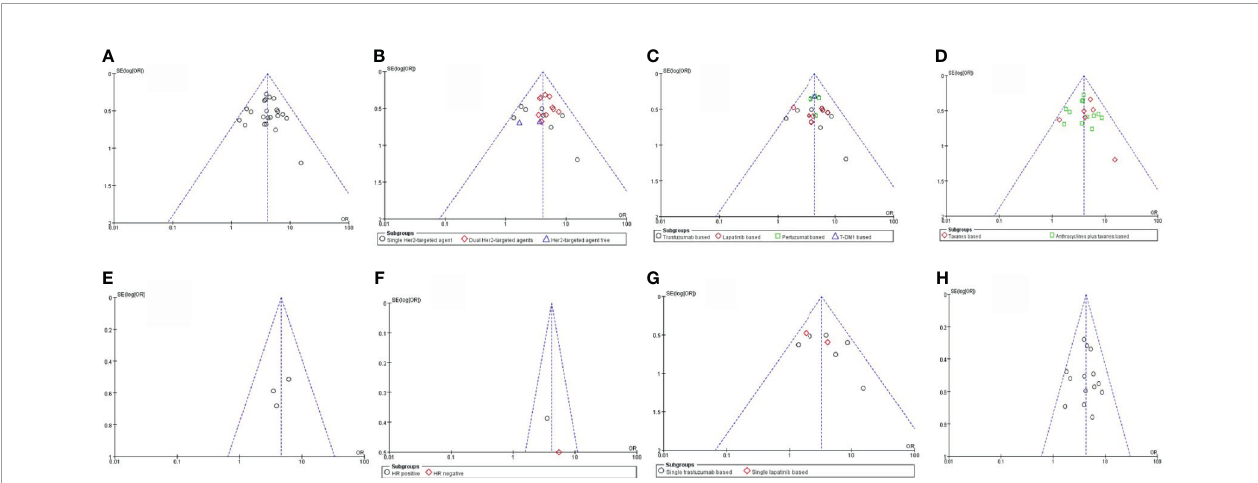
FIGURE 2 | Risk of bias assessment. (A) Her2-enriched vs Non-Her2-enriched subtype (B) The number of Her2-targeted agents (C) The category of Her2-targeted agents (D) Different chemotherapy regimens (E) Endocrine theraphy (F) Hormone receptor (G) Trastuzumab alone and Lapatinib alone (H) Trastuzumab vs Lapatinib. HER2, human epithelial growth factor receptor 2; HR, hormone receptors